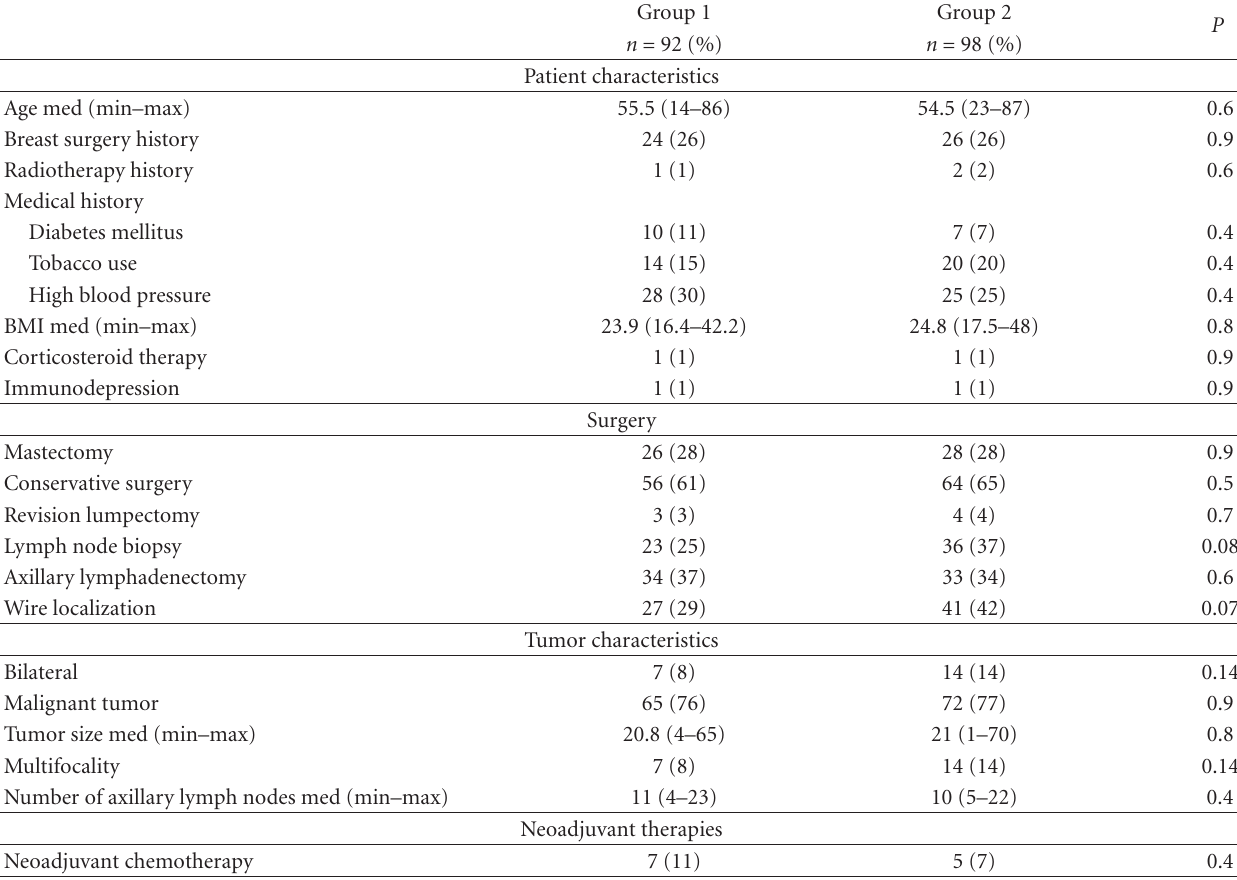
Table 1: Patient, tumor, and surgical